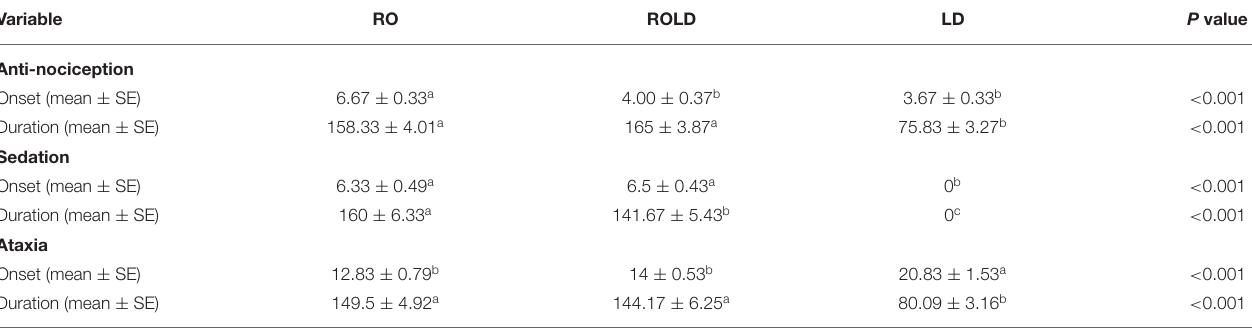
TABLE 2 | Onset and length of perineal anti-nociception, sedation, ataxia (mean ± SE), following epidural injection of romifidine (RO) (50 µ g kg − 1 ), romifidine-lidocaine (ROLD) (50 µ g and 0.3mg kg − 1 ) and lidocaine (LD) (0.3mg kg − 1 ) in camels. Variable